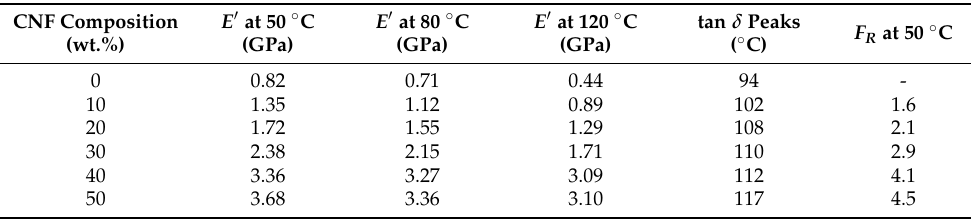
Table 5. Summary of storage modulus, damping factor, and reinforcement factor ( F R ) for neat PA6 and the nanocomposite films at specific temperatures .